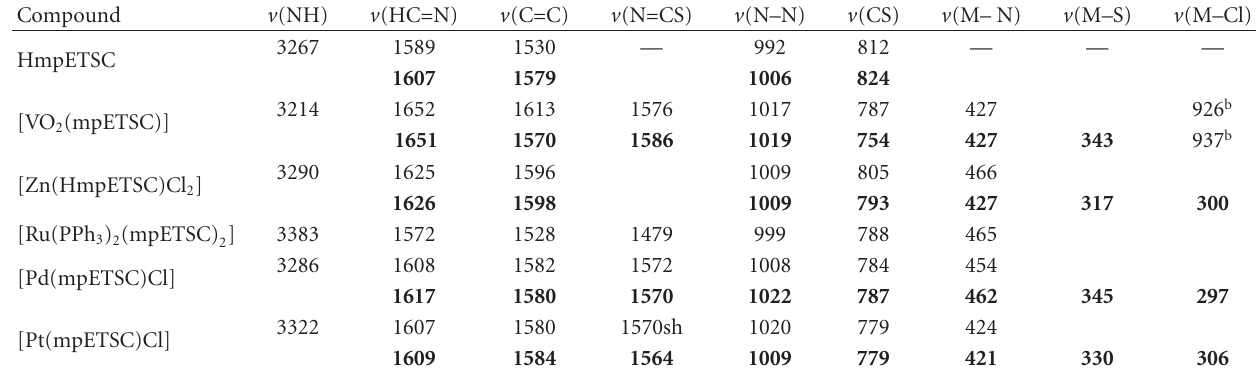
Table 2: Infrared and Raman spectral data of HmpETSC and its complexes a